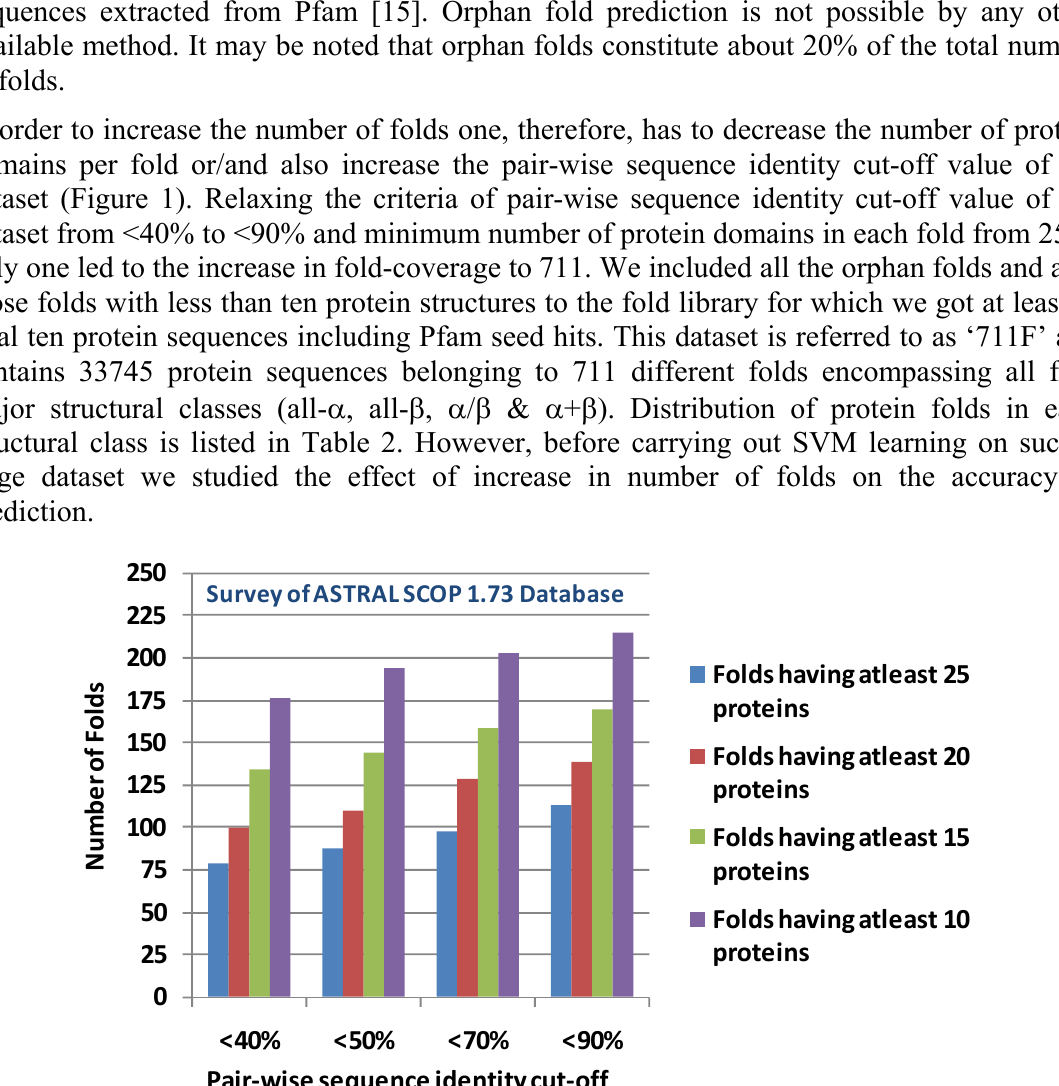
Figure 1: Survey of ASTRAL SCOP 1.73 database: This figure depicts the total number of folds having ≥ 25 protein domains, ≥ 20 protein domains, ≥ 15 protein domains and ≥ 10 protein domains in ASTARL SCOP 1.73 database at 4 different sequence identity cut of values (<90%, <70%, <50% and <40%) of the dataset.